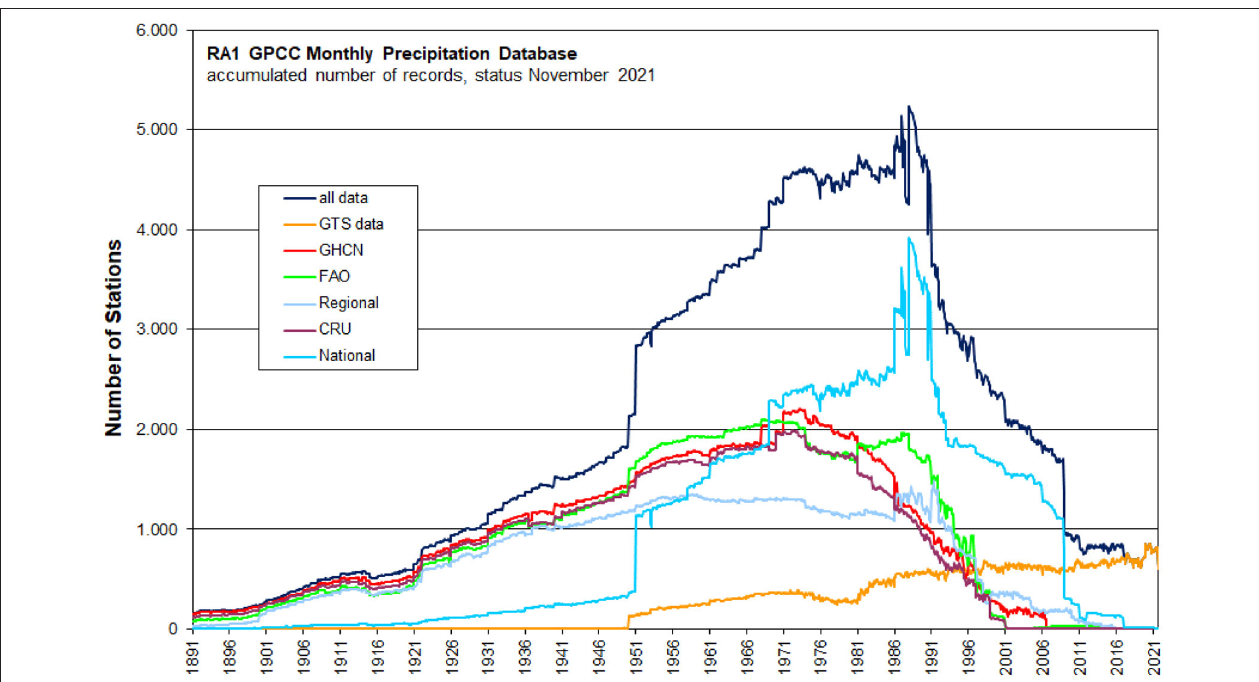
FIGURE 7 | Number of stations per year in the GPCC data base per data source for WMO-region “RA 1” (Africa) and accumulated amount (dark blue). GTS, Global Telecommunication System; GHCN, Global Historical Climatology Network; FAO, Food and Agriculture Organization; CRU, Climatic Research